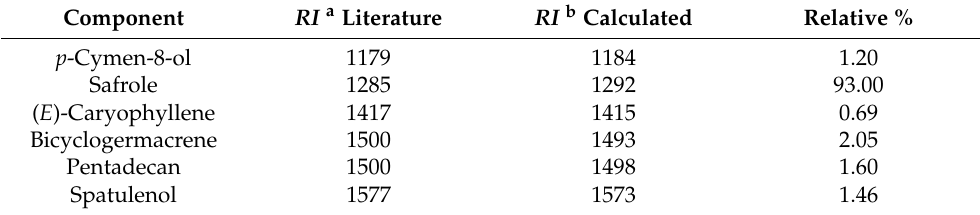
Table 2. Chemical composition of Piper hispidinervum essential oil and relative concentrations of the compounds identified by gas chromatography analysis coupled with mass spectrometry.